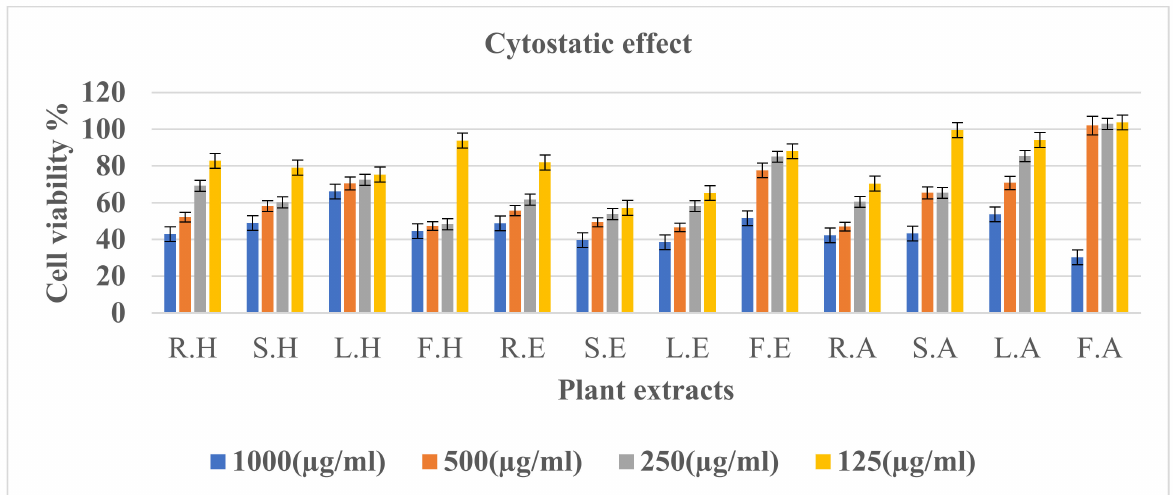
Figure 5. Cytostatic effect of Micromeria fruticose extract effect on colon cell line viability at different studied concentrations after 72 h. Cell viability was calculated as % of absorbance of treated cells to absorbance of control (untreated cells). R: root, S: stem, L: leaf, F: flower, H: hexane, E: ethanol, and A: aqueous. The bars represent means of two replicates ± standard